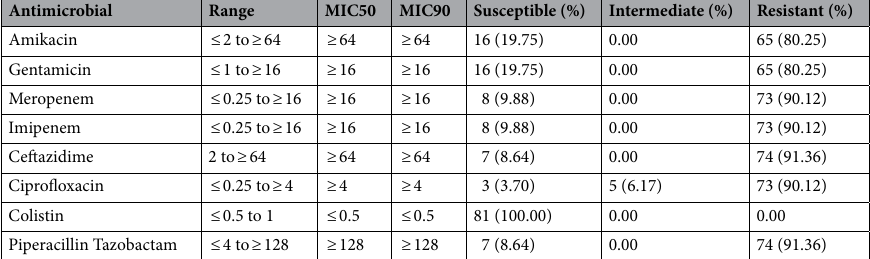
Table 3. MIC50 and MIC90 distributions of all isolates with resistance characteristics.